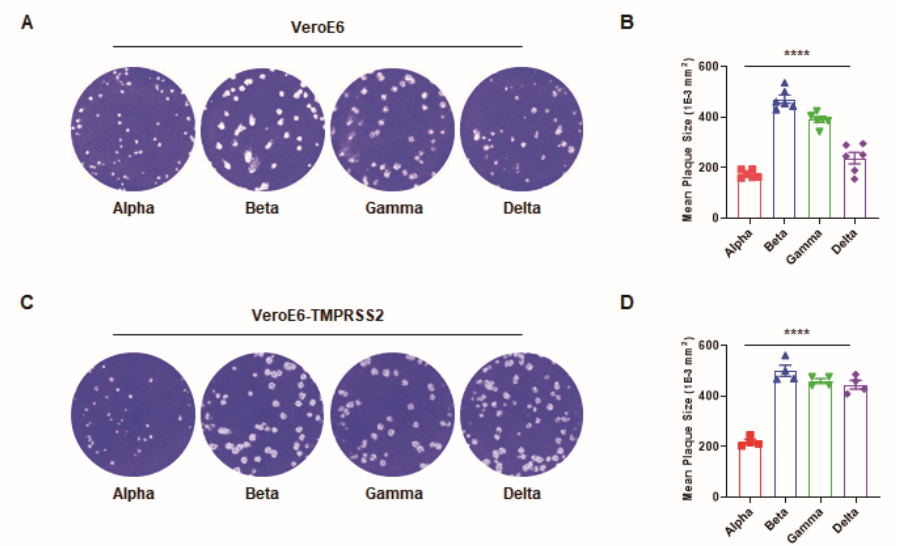
Figure 1. Comparison of the plaque size of four SARS-CoV-2 variants. ( A ) Representative images of the plaque forming assay for each variant of concern in Vero E6 cells. ( B ) The mean plaque size (1 × 10 − 3 mm 2 ) of each variant. ( C ) The images of the plaque forming assay for each variant of concern in Vero E6-TMPRSS2 cells. ( D ) The mean plaque size of each variant. All error bars indicate the standard errors of the mean. Mean values for the plaque size were compared using one-way ANOVA in GraphPad Prism 8.0 software. Statistical significance was set at p < 0.05. (****, p < 0.0001).